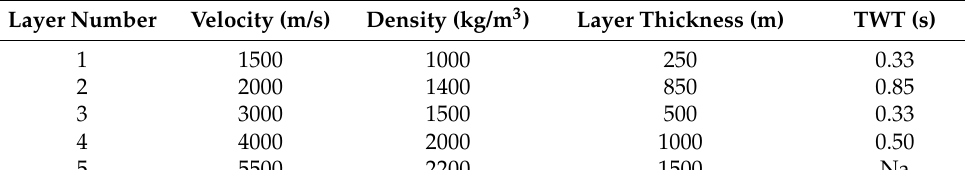
Figure 3. The geological mode used in this study. The red line with blue triangles shows the location of receivers. The dots show 1000 noise sources locations from deeper layers. In ( a , b ) the red line shows the acquisition line above and below the weathered layer, respectively. The sources are randomly distributed below the depth 500 m and within the offset − 4000 to 4000 m. Table 2. The P wave velocities and densities for the model in Figure 3.